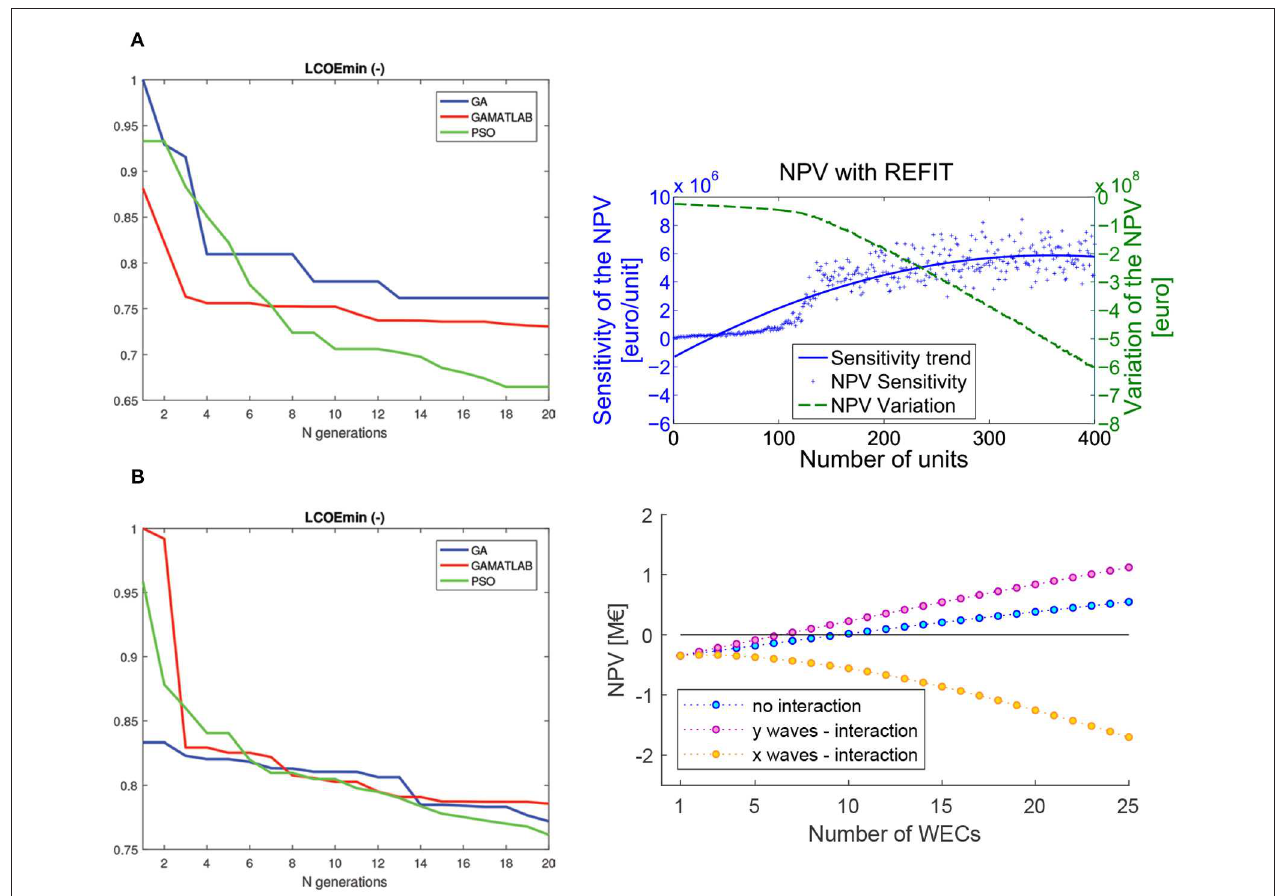
FIGURE 15 | Optimization of wave energy parks based on economic considerations. The economic measures change with number of iterations and with number of devices in the park. (Left) LCOE for arrays of three WaveSub devices optimized with two genetic algorithms and one particle swarm algorithm (Faraggiana et al., 2019). (A,B) show results for different device configurations, showing the dependence on the input values. Upper right: Variation and sensitivity of the net present value (NPV) with the renewable energy feed-in-tariff (REFIT) (Teillant et al., 2012). Lower right: Comparison of the NPV for different park sizes up to 25 WECs when assuming no vs. full hydrodynamic interactions among the devices. The incoming wave directions are either perpendicular to the array layout (“y-waves”) or along the direction of the array layout (“x-waves”) (Giassi et al.,